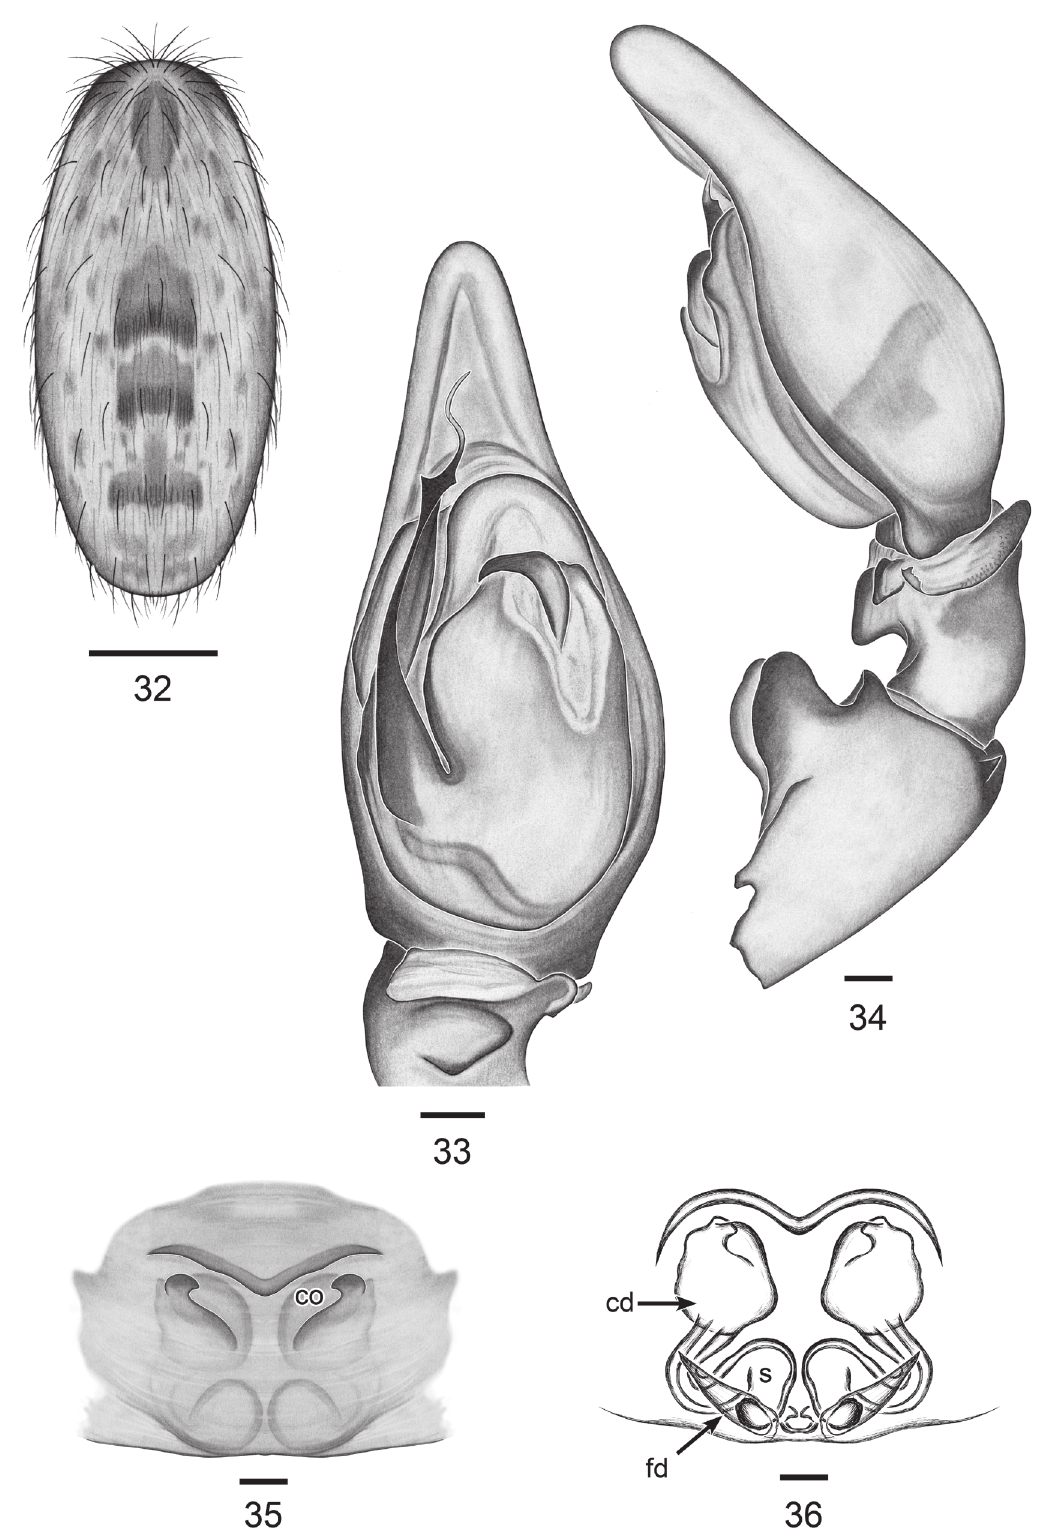
Figs 32–36. Shuyushka moscai gen. et sp. nov. 32 . ♂, abdomen, dorsal view. 33 . ♂, palp, ventral view. 34 . ♂, palp, retrolateral view. 35 . ♀, epigynum, ventral view. 36 . ♀, internal genitalia, dorsal view. Scale bars: 33–36 = 0.1 mm; 32 = 1